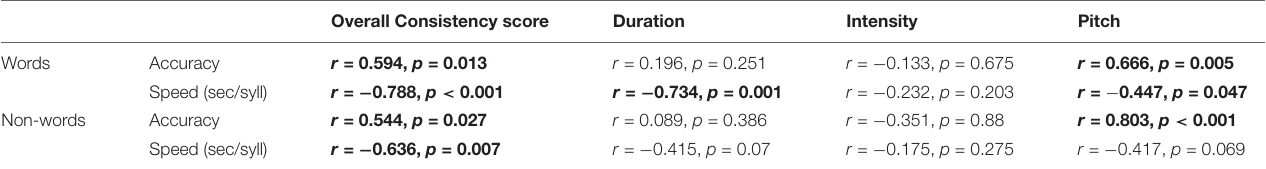
TABLE 3 | Impact of reading performance (DDE-2, Sartori et al., 2007) on Stress Perception parameters in the DD group.